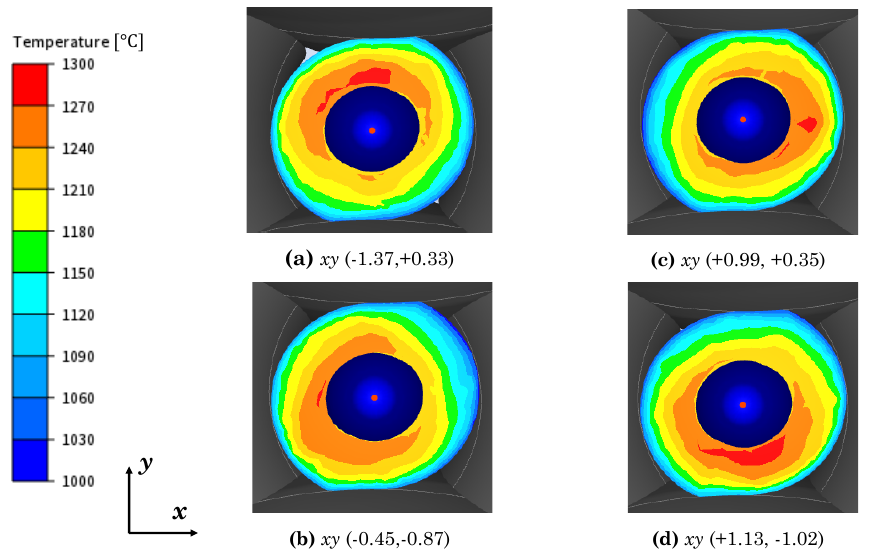
Figure 15. Displacement of the tip of the plug to the softer region of the pierced material, the coordinates of the sensor in the xy plane is